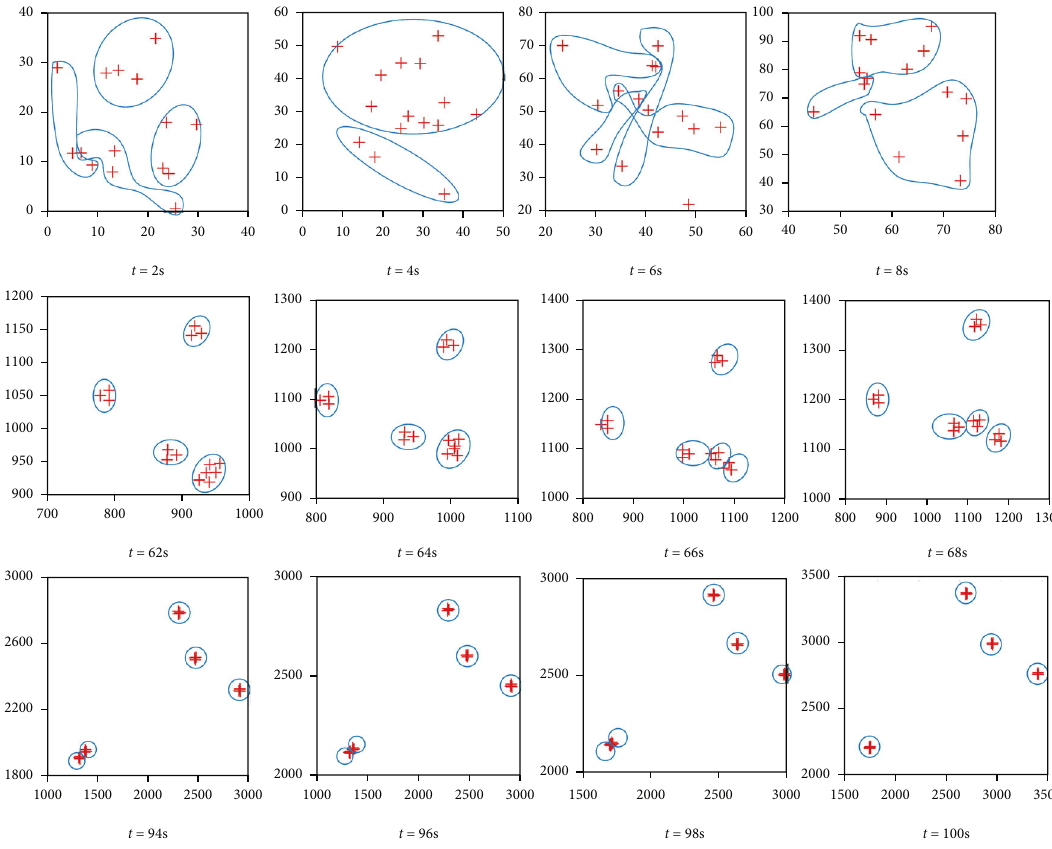
Figure 14: Cluster identi fi cation results at speci fi c